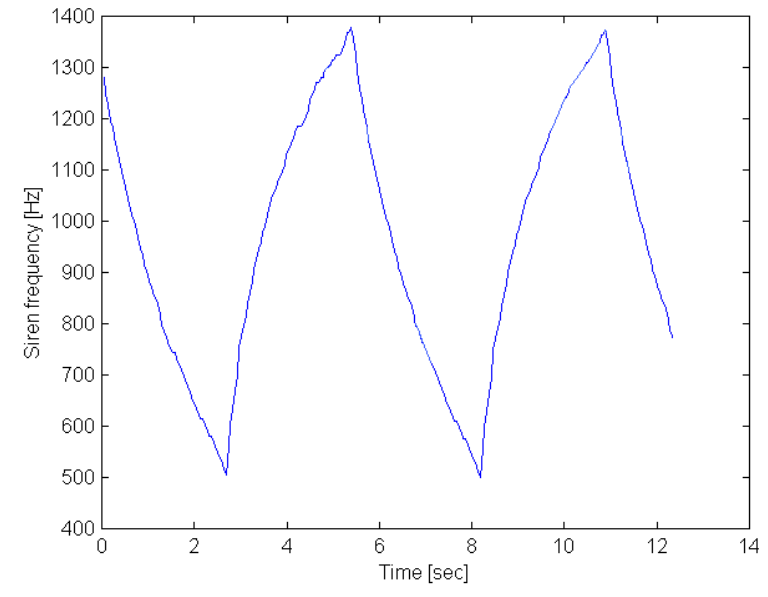
Figure 3. A frequency characteristic curve derived from a recorded signal of an ambulance